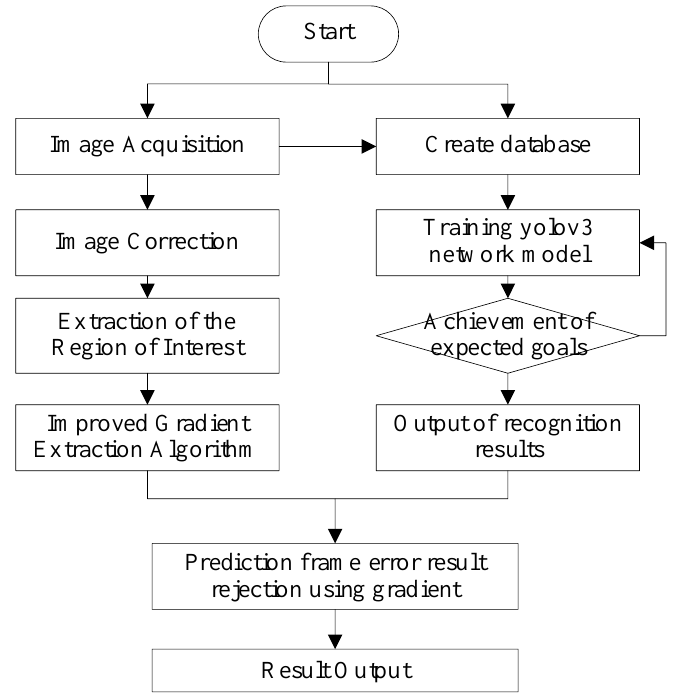
Figure 2. Flowchart of the identification and localization algorithm of sugarcane stem nodes combin- ing YOLOv3 and traditional methods of computer vision.